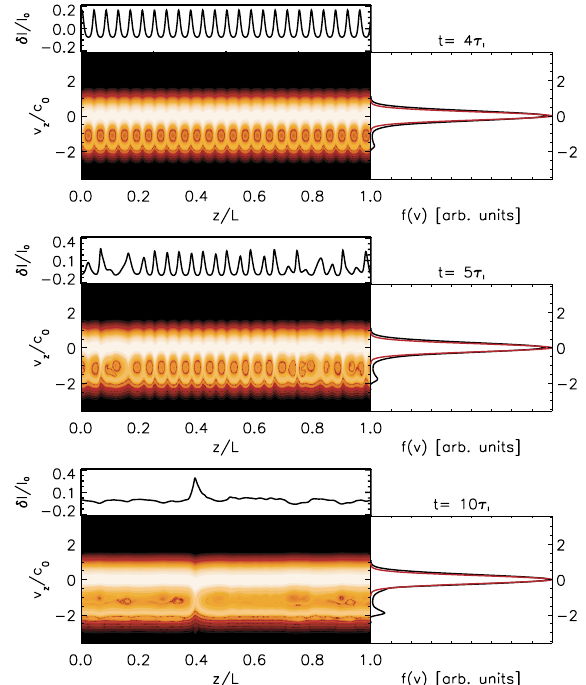
FIG. 10. (Color) Contour plots of the distribution function ln f (cid:2) z , y z (cid:3) together with the line density r L (cid:2) z (cid:3) and the velocity distribution f (cid:2) y z (cid:3) obtained from the Vlasov simulation (with L (cid:2) 10 m) for U sc (cid:2) 10 , V bb (cid:2) 0.1 , and n r (cid:2) 24